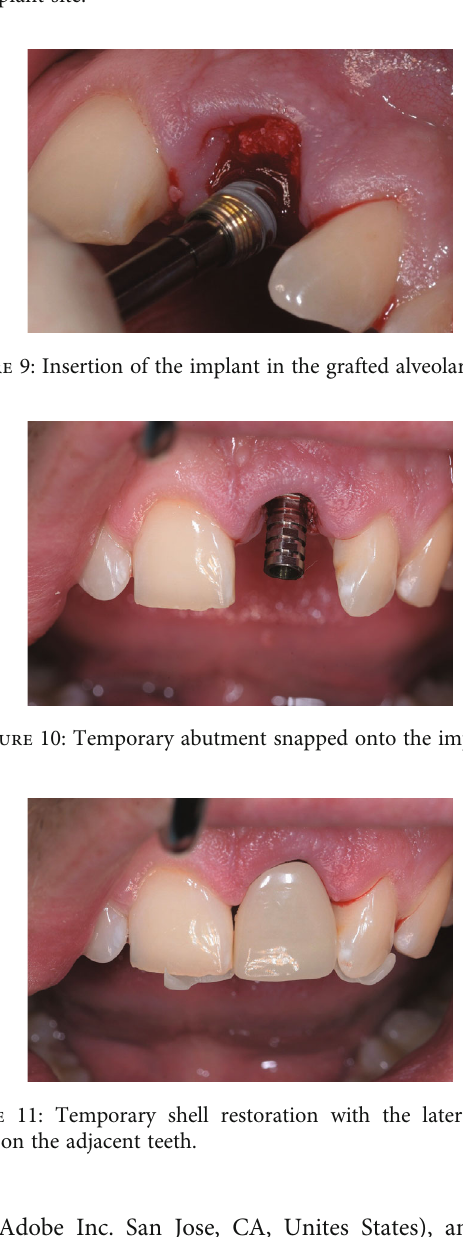
Figure 12: Emergence pro fi le of the fi nished and polished temporary restoration.